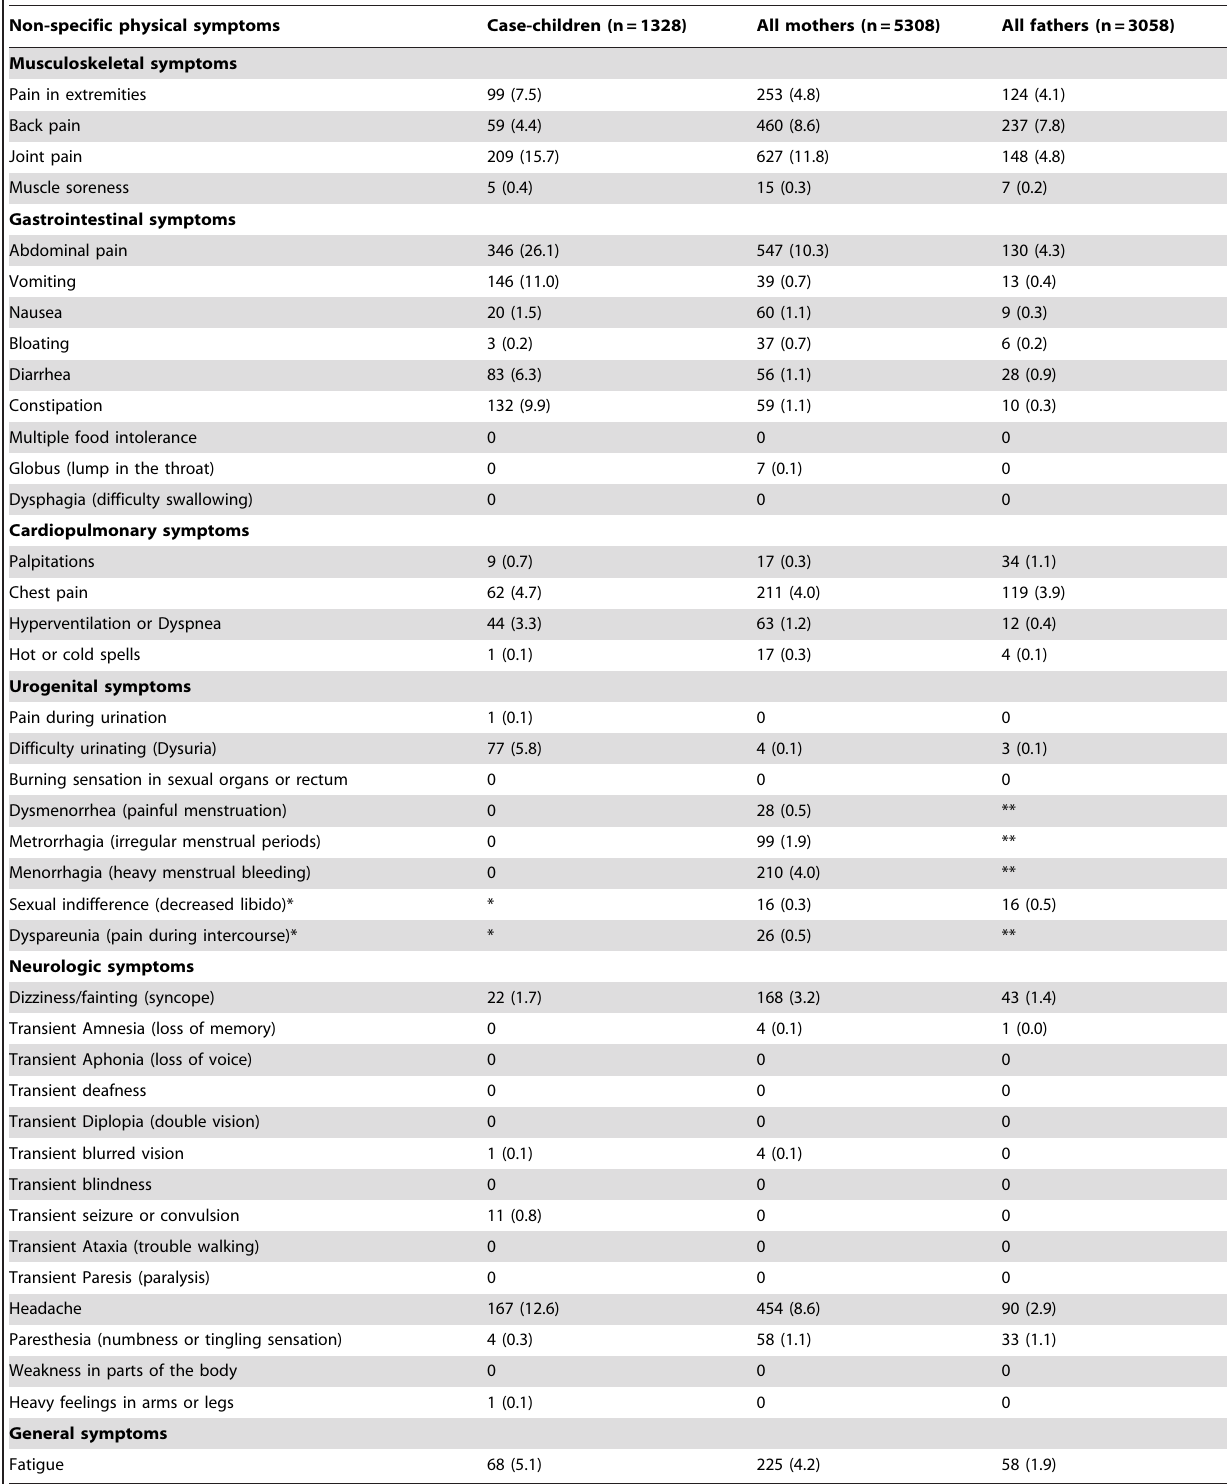
Table 1. List of NSPS and their distribution in children and